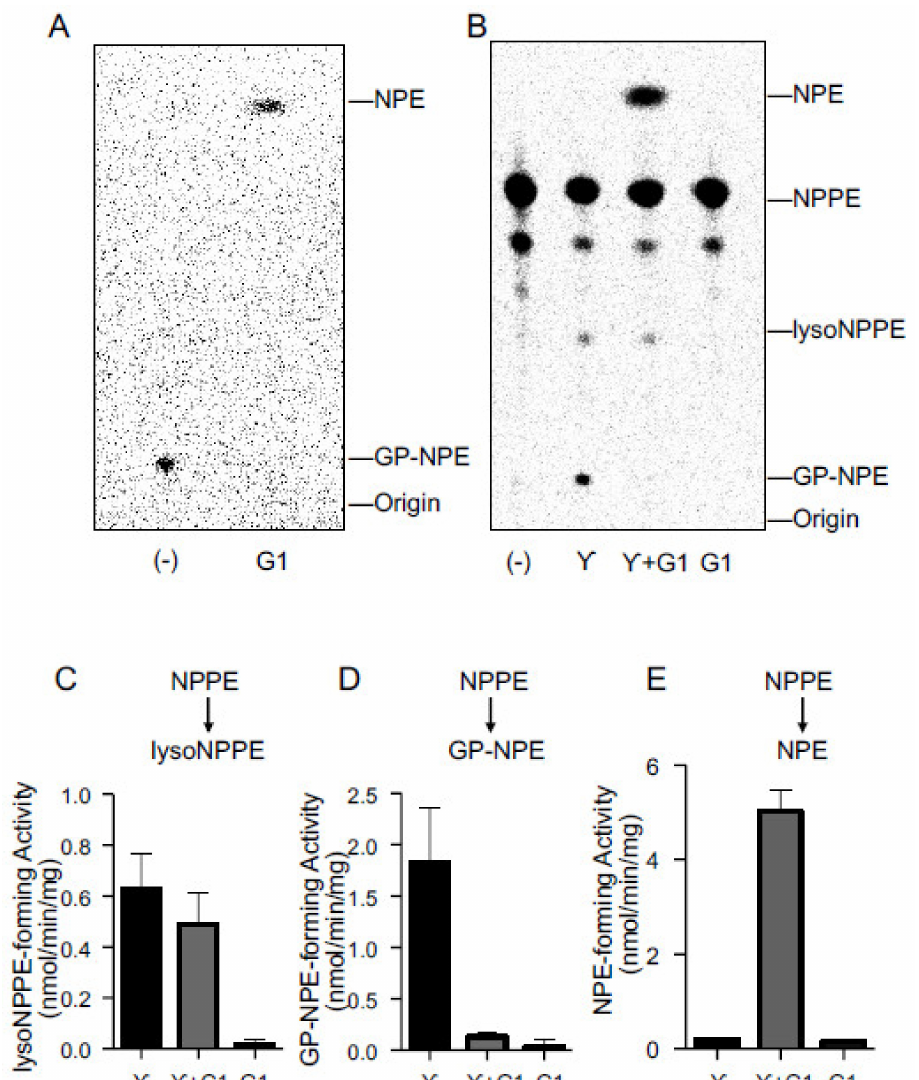
Figure 6. The formation of NAE from GP-NAE by GDE1. The radioactive band corresponding to GP- N -[ 14 C]palmitoylethanolamine (GP-NPE), which was produced by purified cPLA 2 γ , was scraped from the TLC plate. The radioactive compound was then extracted by the Bligh and Dyer protocol, and incubated with purified GDE1 (G1) or water (-) ( A ). N- [ 14 C]Palmitoyl-PE (NPPE) was incubated with the purified cPLA 2 γ for 30 min and additionally with the purified GDE1 for 15 min ( γ +G1) ( B ). GDE1 or cPLA 2 γ was omitted in γ and G1, respectively. The products were analyzed by TLC. The positions of the origin and authentic compounds are shown. The N -[ 14 C]palmitoyl-lysoPE (lysoNPPE)-forming activity ( C ), GP-NPE-forming activity ( D ), and N -[ 14 C]palmitoylethanolamine (NPE)-forming activity ( E ) are shown (mean values ± S.D., n = 3). As for human cPLA 2 γ , Northern blot analysis indicated that cPLA 2 γ mRNA is most abundant in the skeletal muscle and heart, with lower levels in the spleen, brain, placenta, and pancreas [20]. Human cPLA 2 γ (accession number, NP_003697) [20] and mouse cPLA 2 γ (NM_001004762) were deduced to comprise 541 and 597 amino acids, respectively. Arg- 54, Ser-82, and Asp-385, forming the catalytic center of human cPLA 2 γ , were conserved as Arg-55, Ser-83, and Asp-417 in mouse cPLA 2 γ [17]. Human cPLA 2 γ [20] and mouse cPLA 2 γ (Guo et al., unpublished observation) showed the PLA 1 /A 2 activity for PC. Thus, human cPLA 2 γ was considered to be the ortholog of the mouse